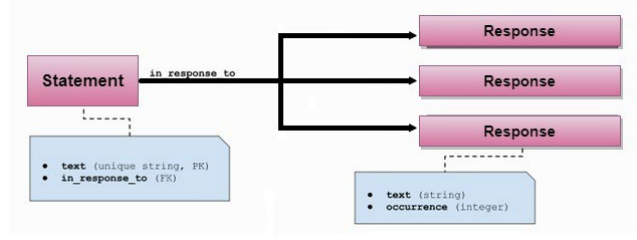
Fig. 3. Statement-response relationship.